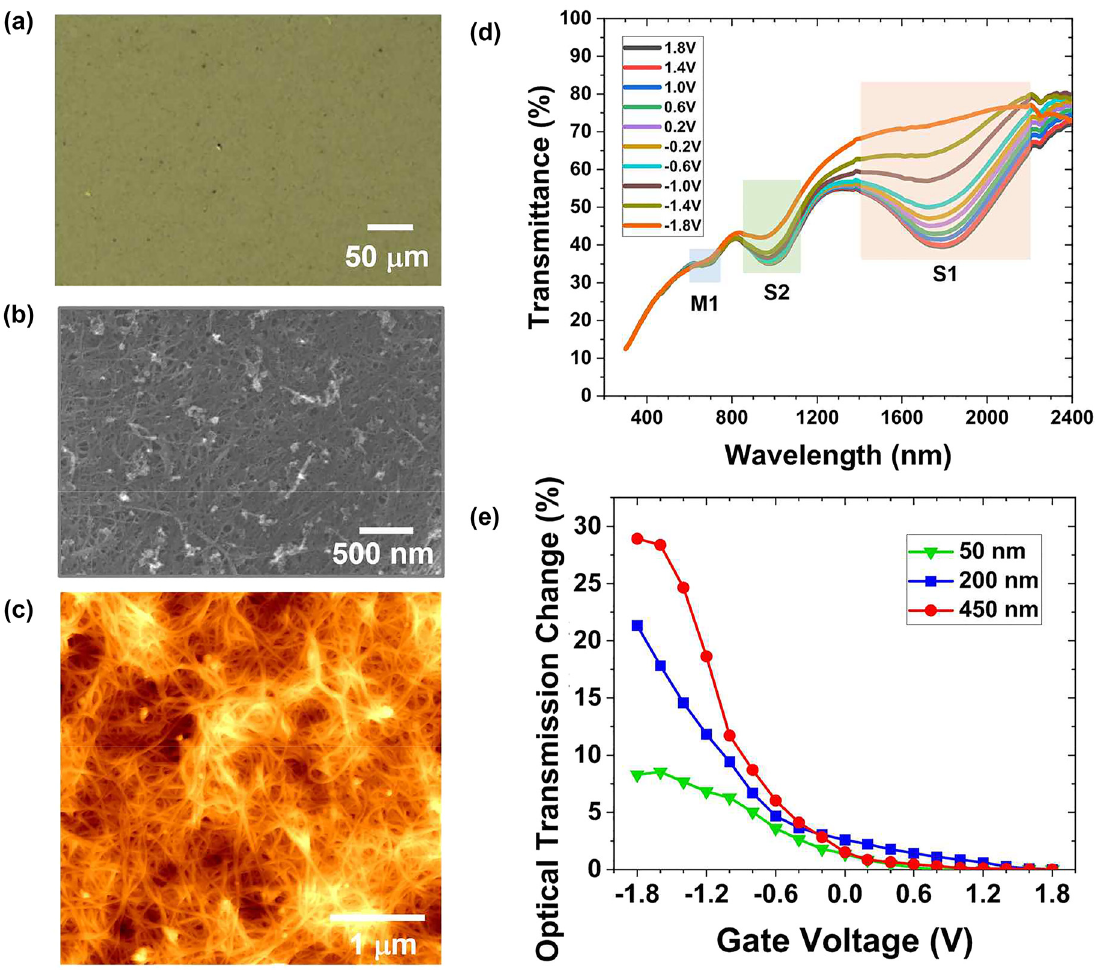
Figure 1: A fabricated 200 nm-thick CNT network film (a) Optical microscope image. (b) Scanning electron microscope image, and (c) Surface morphology measured by atomic force microscopy. (d) Measured optical transmittance of 200 nm-thick CNT network film as a function of applied gate voltage from + 1.8 V to − 1.8 V. (e) Thickness-dependent response change in optical transmission of CNT network film at the wavelength of 1550 nm via ion-gel gating from + 1.8 V to − 1.8